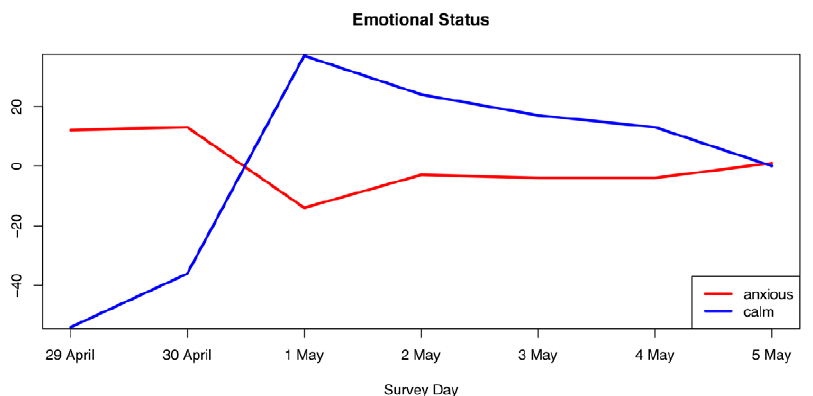
Figure 8. Changes in difference between observed and expected values of the emotional status over the seven days of the survey. The pattern is significantly different from the expected pattern based on marginal frequencies ( x 2 =135.6, df =48, p ,